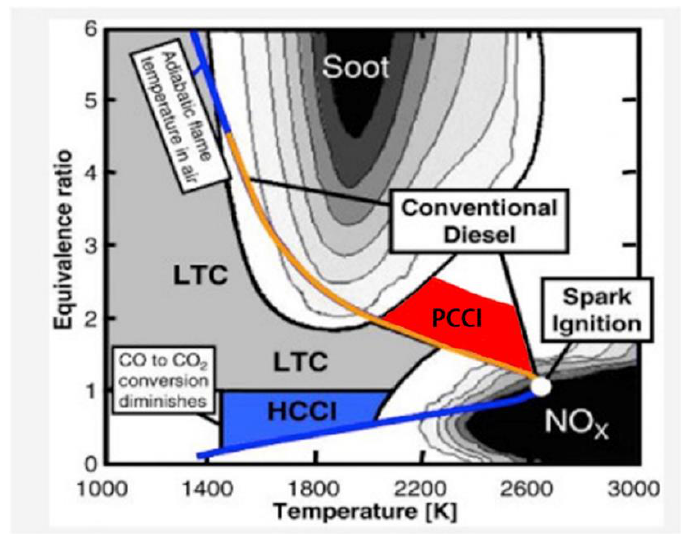
Figure 1. φ -T diagram of conventional combustion, homogeneous charge compression ignition (HCCI) combustion, and premixed charge compression ignition (PCCI) combustion [11]. φ , equivalence ratio; T, temperature.